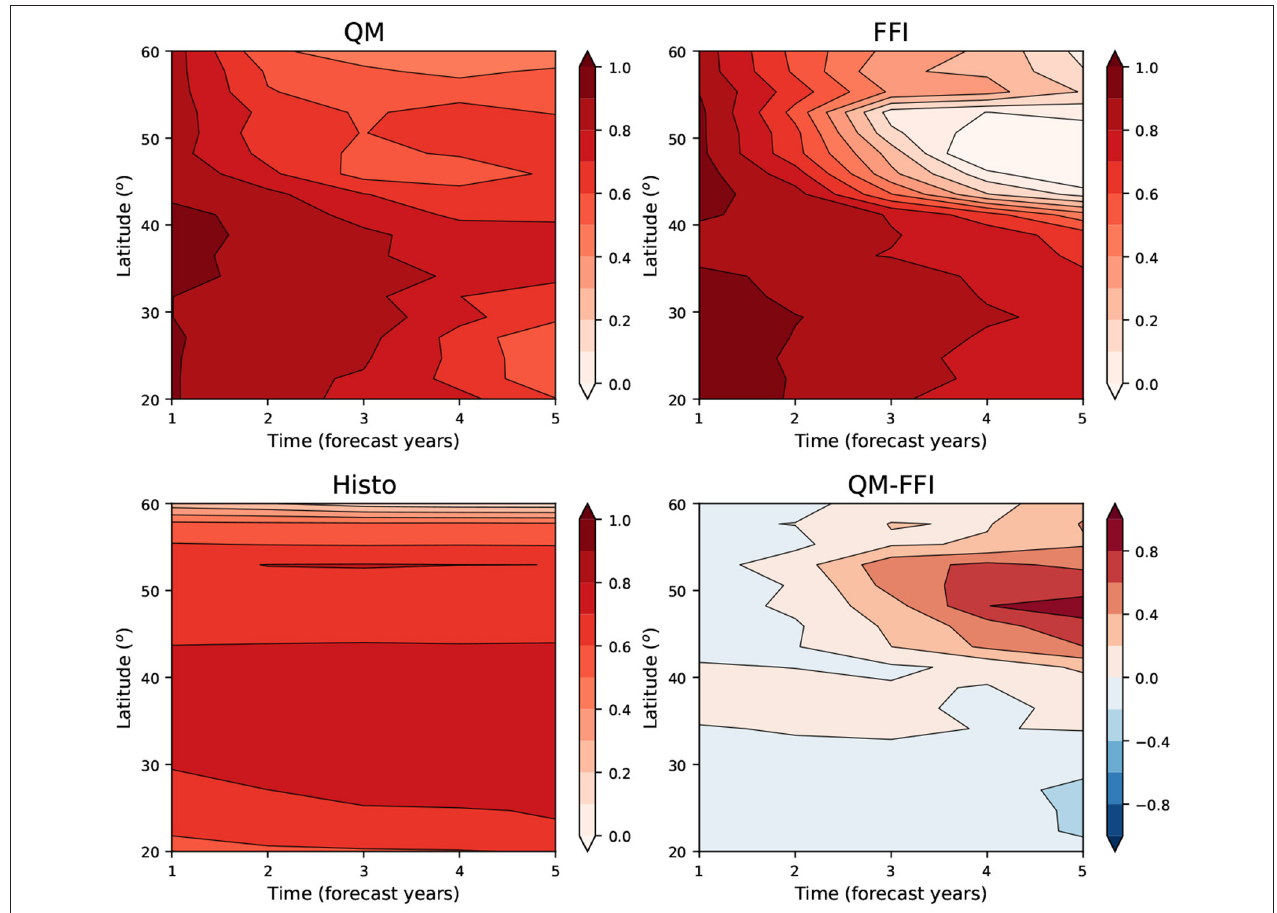
FIGURE 9 | Hovmoller diagrams of the AMOC anomaly correlation with NEMOVAR-ORAS4. The Atlantic Meridional Overturning Circulation (AMOC) is calculated as the maximum of the Atlantic meridional overturning stream function over adjacent boxes of 2 ◦ latitude (from 20 ◦ to 60 ◦ N) and 900–3,000 m depth. The panels show, respectively, the quantile matching (QM) (top left) , the full-field initialization (FFI) (top right) , the Histo (bottom left) , and the difference between the QM and the FFI skill (bottom right) .